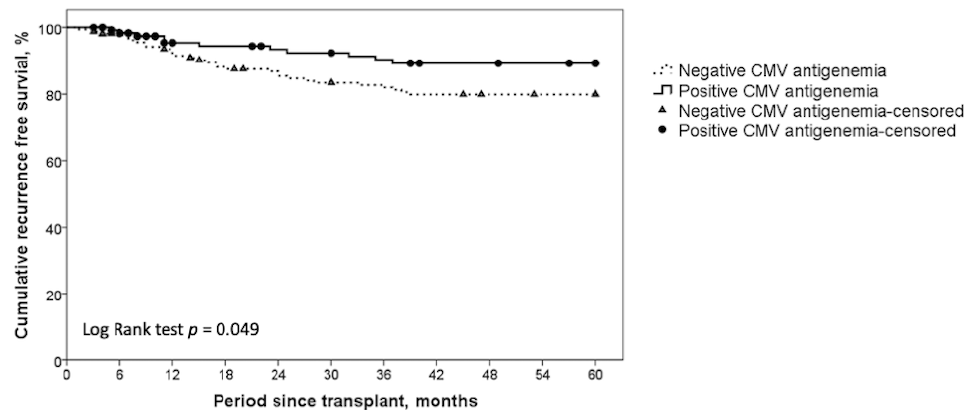
Figure 1. Kaplan–Meier method for five-year cumulative recurrence-free survival (RFS) depending on CMV antigenemia positivity and negativity. Positive CMV antigenemia group showed a significantly superior five-year RFS.